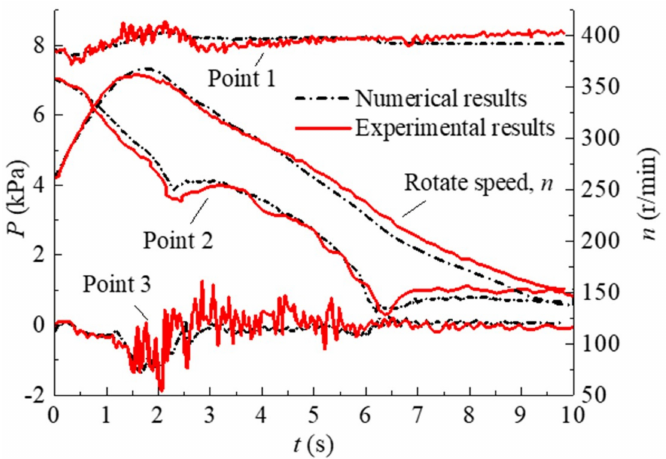
Figure 9. Curves of numerical simulation and experiment